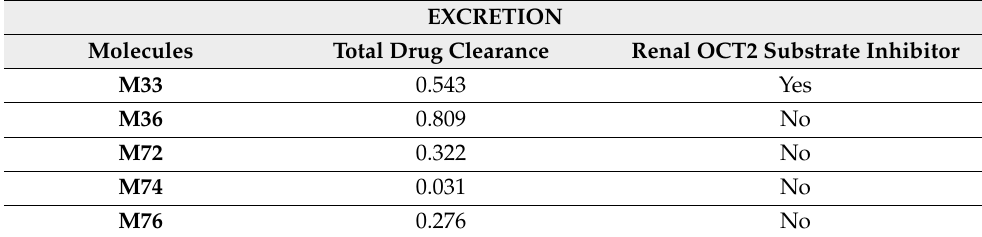
Table 6. Various excretion profiles of the proposed pyrazole